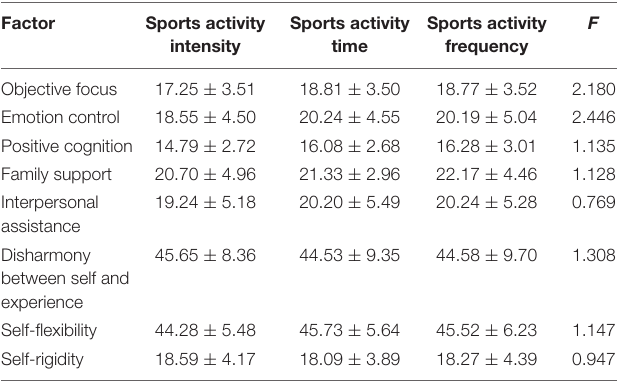
TABLE 3 | Difference between sports activity participation and mental toughness and self-harmony.